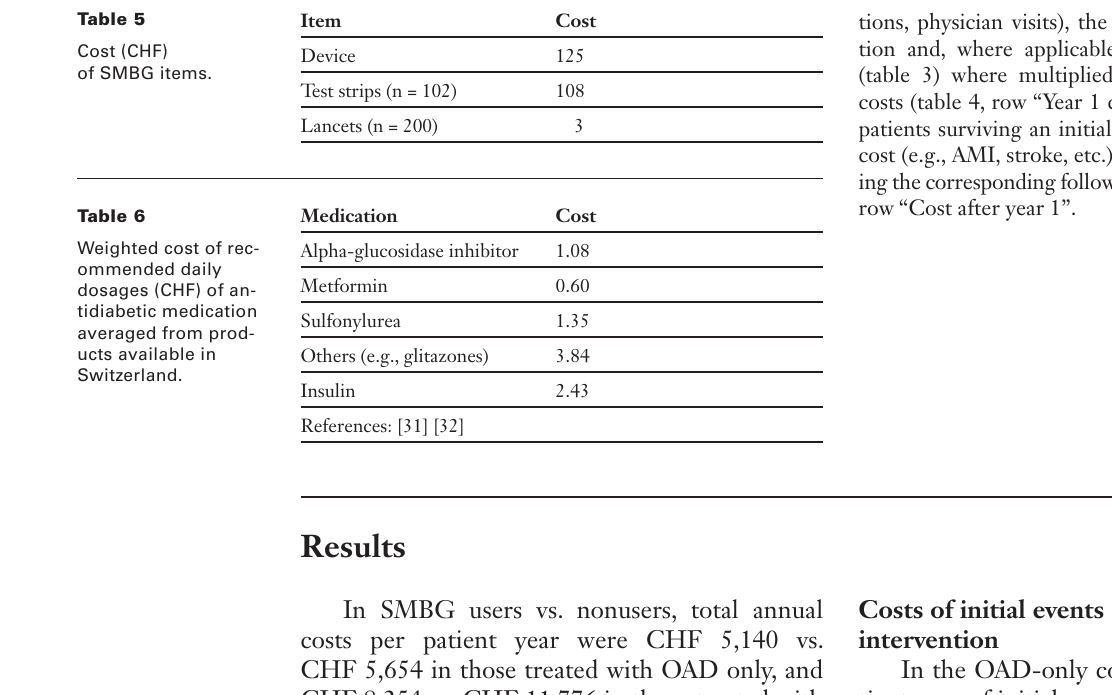
Cost per patient-year (CHF) in cohort using oral antidiabetic drugs only.